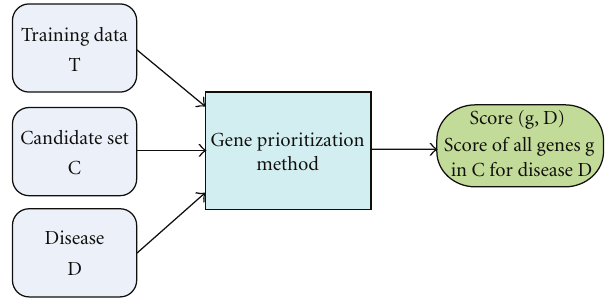
Figure 1: General gene prioritization